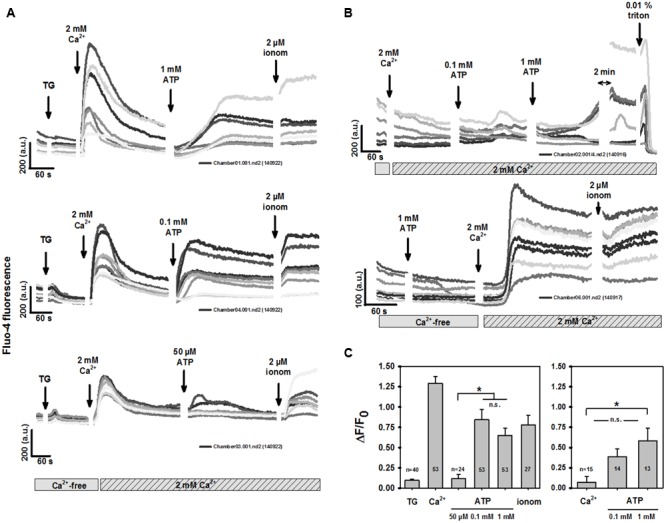
Murine BV2 microglia cells show robust store-operated Ca2+ entry (SOCE). (A) Representative recordings of two-photon excited fluo-4 Ca2+ fluorescence from several individual BV2 cells. Under Ca2+-free conditions, thapsigargin (TG) was introduced to empty internal stores, followed by addition of 2 mM external Ca2+ which induced a robust Ca2+-entry with transient rise in intracellular global Ca2+. Following decline of SOCE, extracellular addition of ATP induced a delayed sustained rise in Ca2+ in a concentration-dependent manner. This was almost complete for 0.1 mM and 1 mM ATP as judged from the response towards Ca2+ permeabilization by ionomycin (C). (B) Omitting store-depletion prior to introducing external Ca2+ did not induce any SOCE response. External addition of ATP induced Ca2+ influx into BV2 cells because addition of ATP under Ca2+-free conditions (lower panel) abrogated the rise in Ca2+ fluorescence until extracellular Ca2+ was added. (C) Statistical analysis of SOCE and ATP-mediated Ca2+ entry. The right panel refers to experiments such as shown in (B), upper panel, where Ca2+ was added externally to BV2 cells without prior store-depletion.